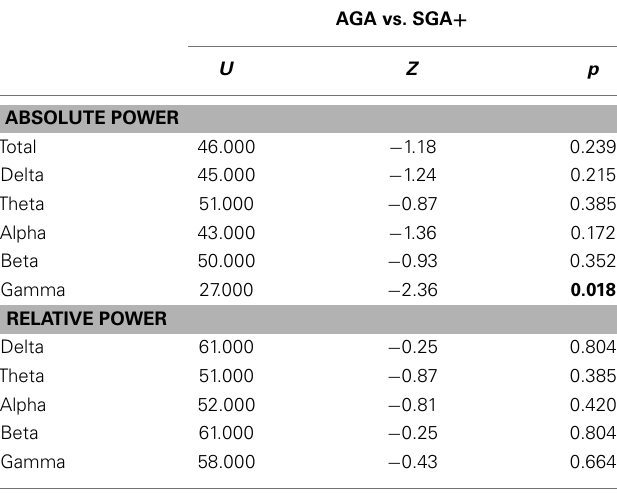
Table 2 |Test statistics for absolute and relative